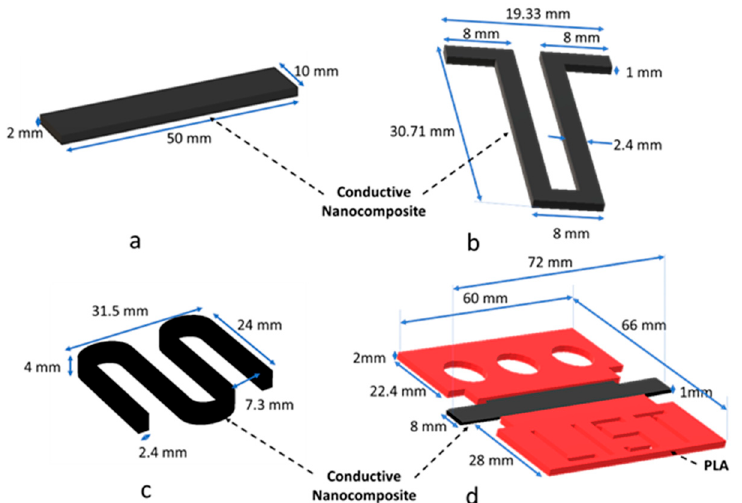
Figure 1. 3D-printed specimens with the conductive composite (PEU70PLA30MWCNT14): ( a ) rec- tangular bar used for mechanical characterization ( b ) U-shaped resistor ( c ) linear compression de- vice; ( d ) hinge 3D printed with non-conductive PLA (red) and a conductive composite (black).